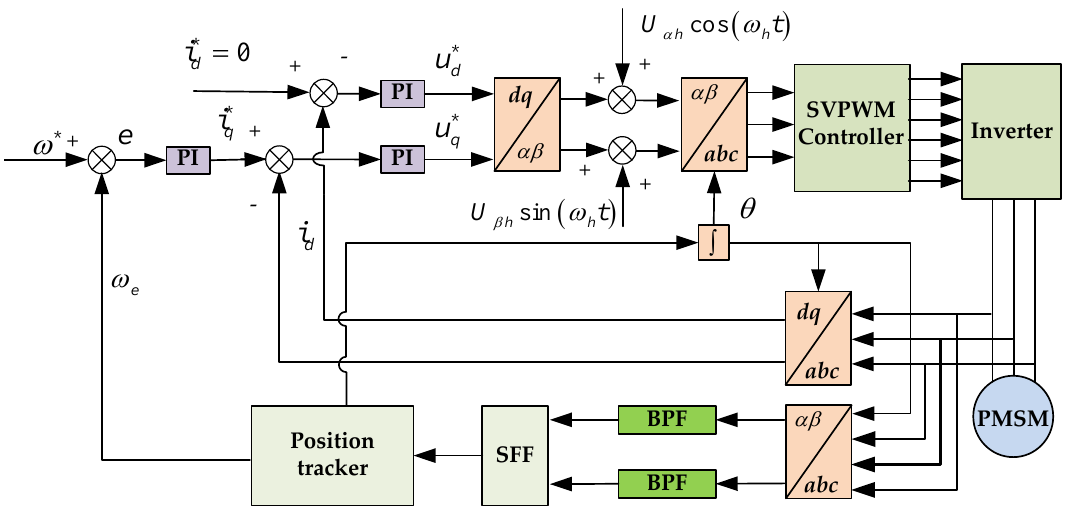
Figure 2. Block Diagram of rotating HF Voltage injection method.